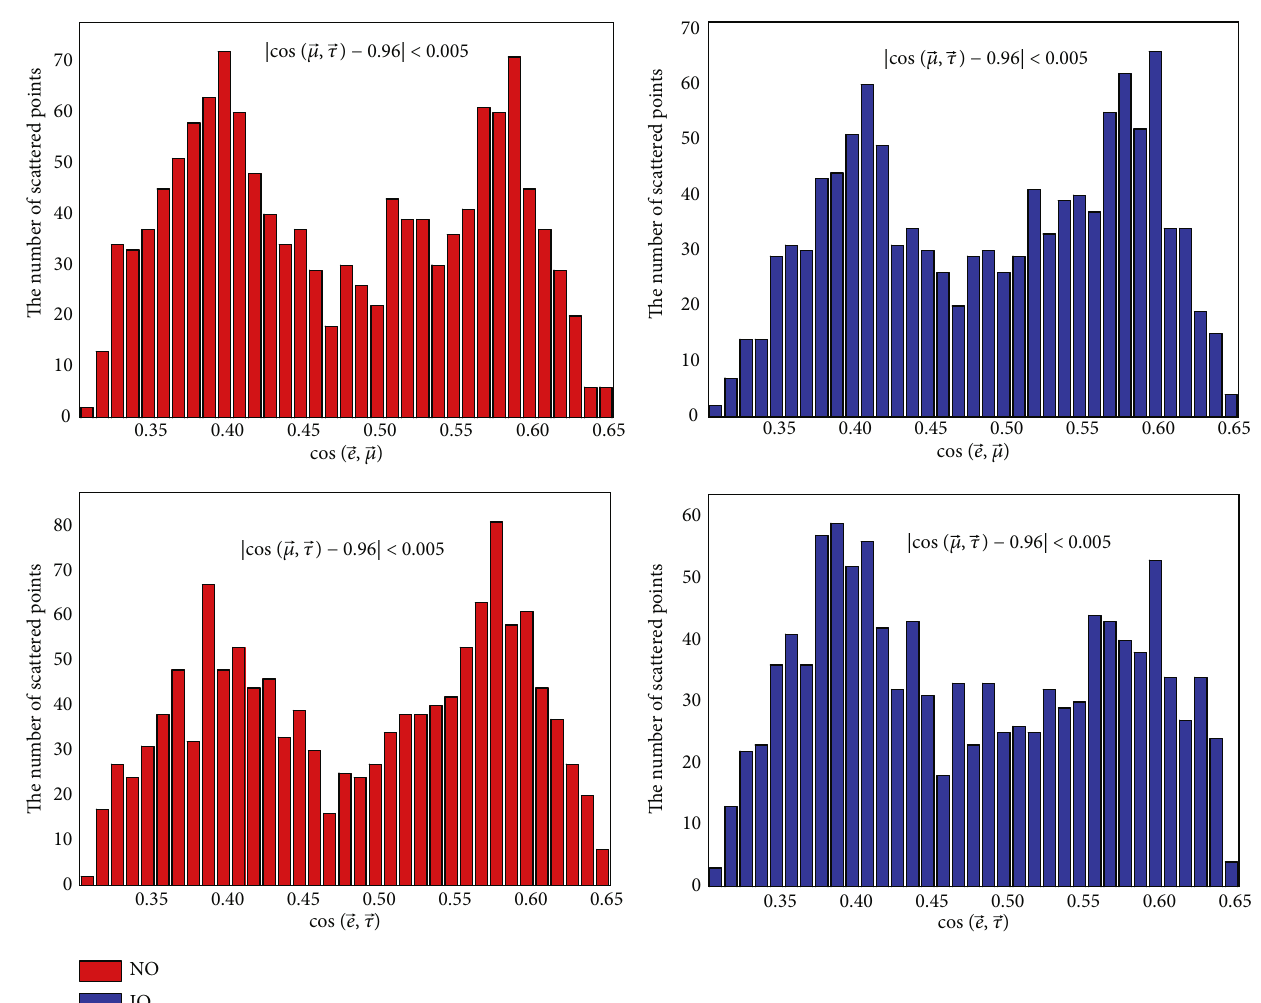
Figure 4: The number of scattered points corresponding to a series of small intervals of cos ð e ! , μ ! Þ and cos ð e ! , τ ! Þ in Figure 2, with the ! Þ − ! constraint of j cos ð μ , τ 0 : 96 j < 0 : 005 . Red: NO case. Blue: IO